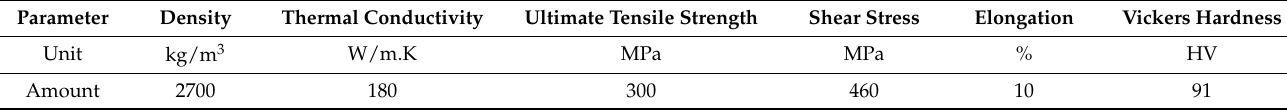
Table 1. Mechanical properties of base